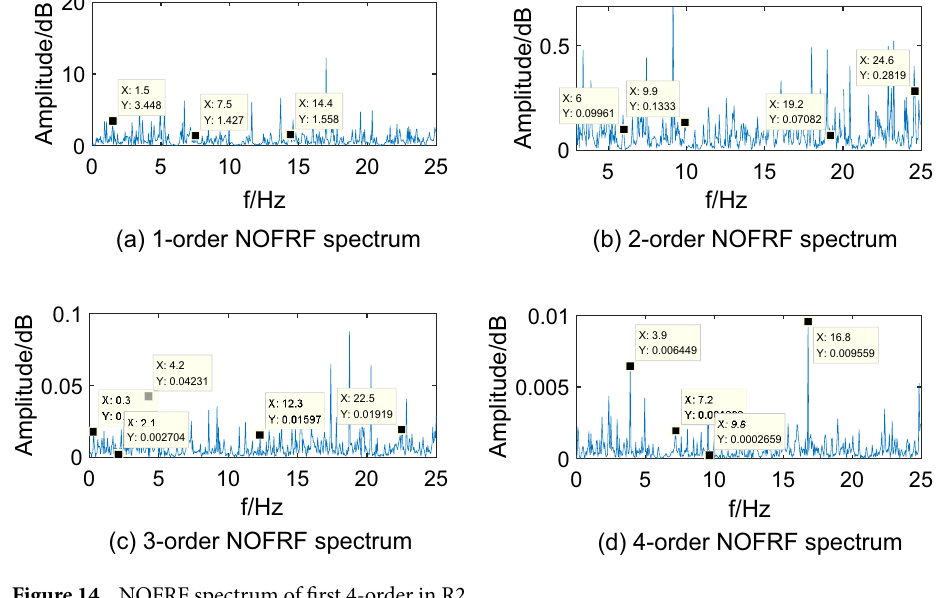
Figure 14. NOFRF spectrum of first 4-order in R2.